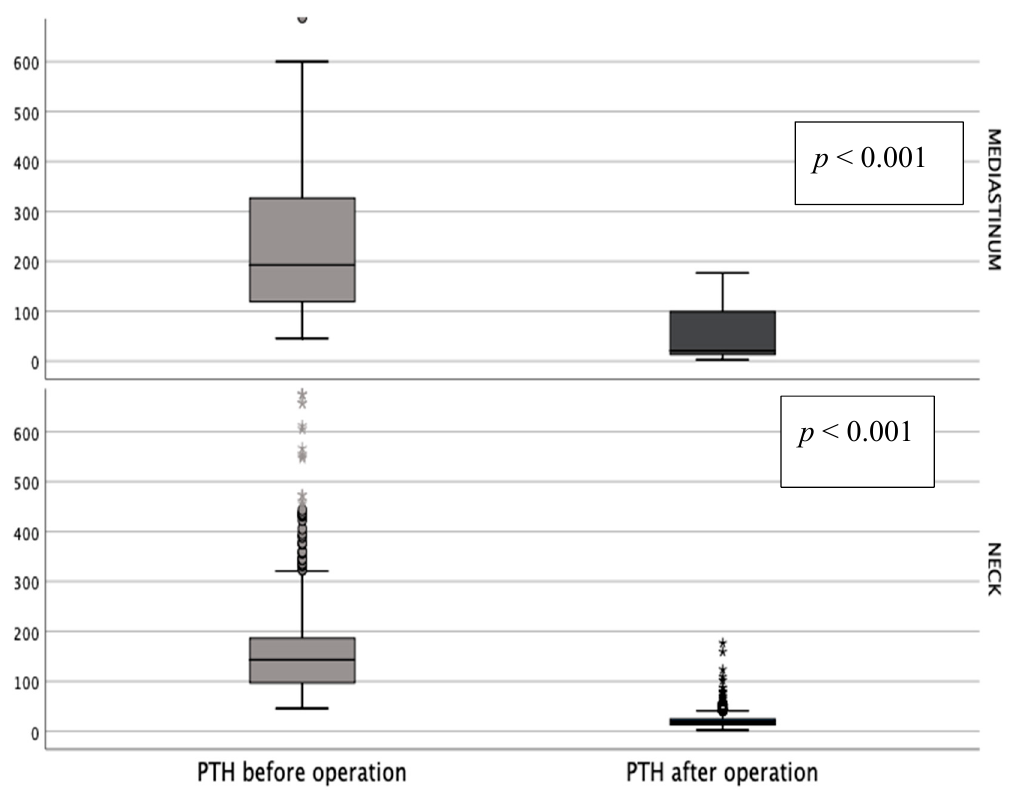
Figure 3. Blood serum parathormone (PTH) concentration before and after operation (* - p < 0.001).